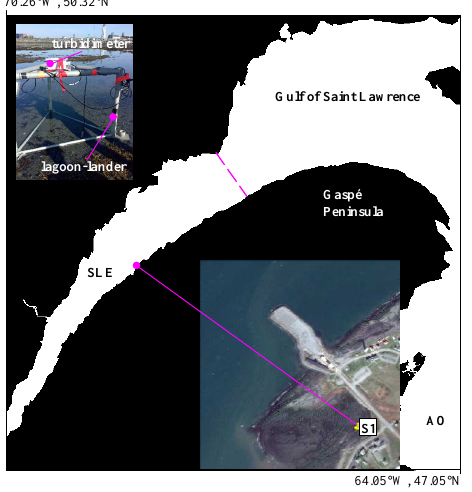
Figure 2. Study area. S1: sampling location, in situ instrumentation (inset upper-left corner), SLE: Saint Lawrence Estuary, AO: Atlantic Ocean